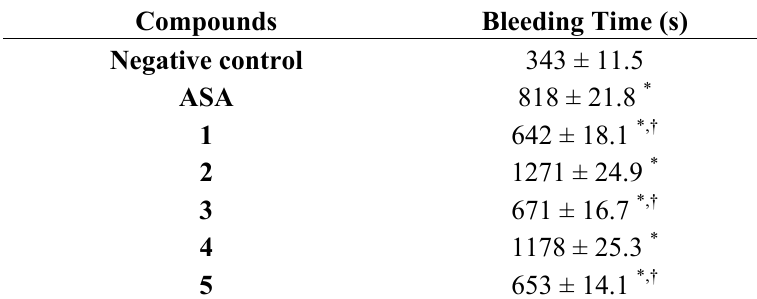
Table 2. Effects of compounds 1 – 5 and ASA on bleeding time in vivo